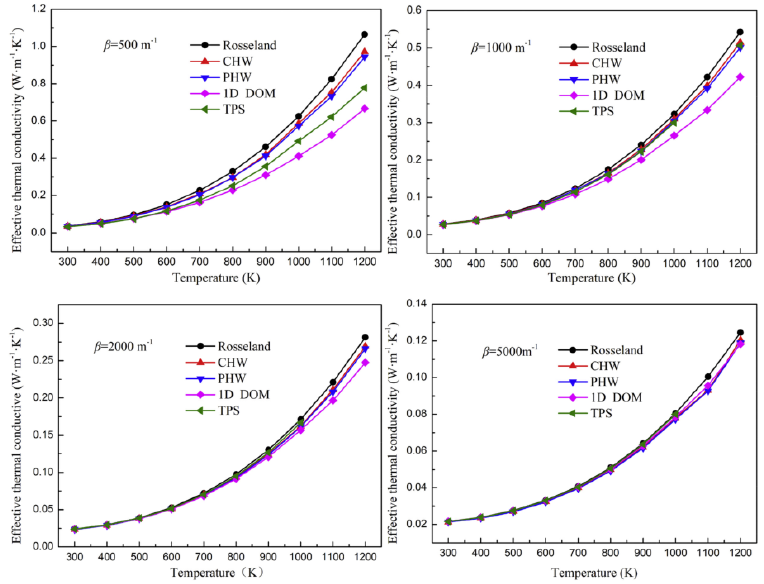
Figure 22. Influence of temperature.